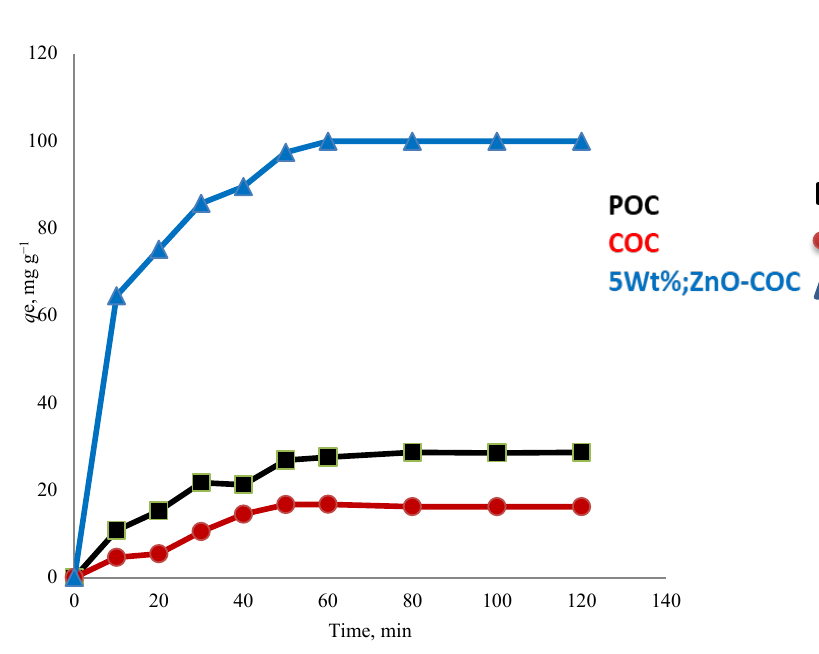
Fig. 5. Kinetics of the adsorption of MB on (■) purified clay (●) calcined clay and (▲) impregnated clay with ZnO (pH = 6.8; m = 0.025 g; V = 50 mL; Ci = 50 mg L –1 ; T = 24 °C). As the result, the uptake ratio and adsorption amount of methylene blue onto (05wt%ZnO-COC) is extremely higher than the others samples. The maximum adsorption quantity of MB at equilibrium time are 100 mg g –1 , 26.77 mg g –1 and 16.79 mg g –1 of impregnated, purified and calcined clays, respectively. The difference in equilibrium time probably is due to the strong electrostatic (attractive) forces between the dye molecules and the impregnated sample (05wt%ZnO-COC). The kinetic rates were evaluated by the pseudo-first-order model [38] and the pseudo-second-order model (Fig. 6). The pseudo-first order model is given by Eq. (2).